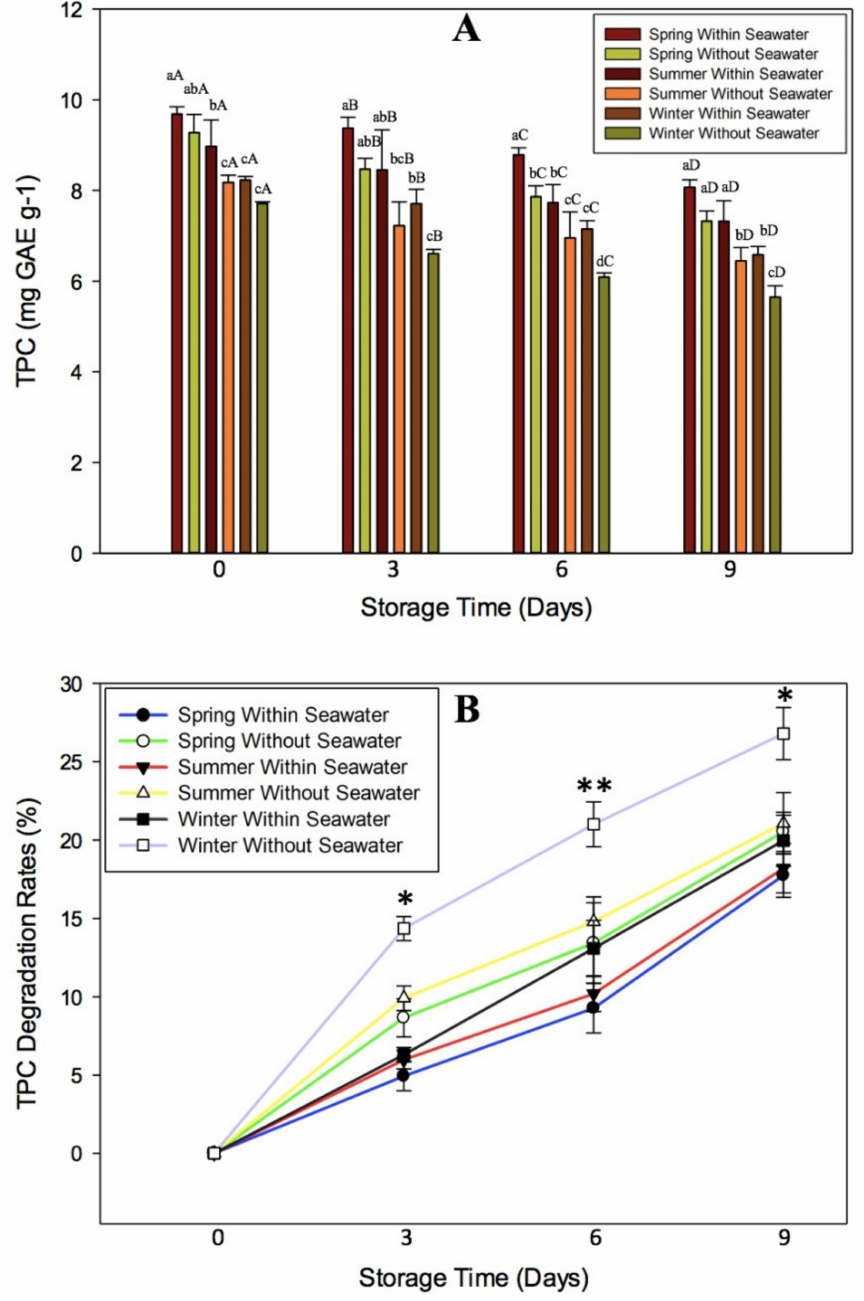
Figure 4. Oxidative stress effect on total phenolic content of seagrape in different seasons during post- harvest storage ( A ) total phenolic content (TPC) ( B ) TPC degradation rates. The data express means ( n = 3) with the error bar shows standard deviation. a–d Means express the significant differences in the same storage time ( p < 0.05). A–D Means express the significant differences in the same treatment ( p < 0.05). The star marks express the significant differences as respectively * ( p < 0.05), and ** ( p <